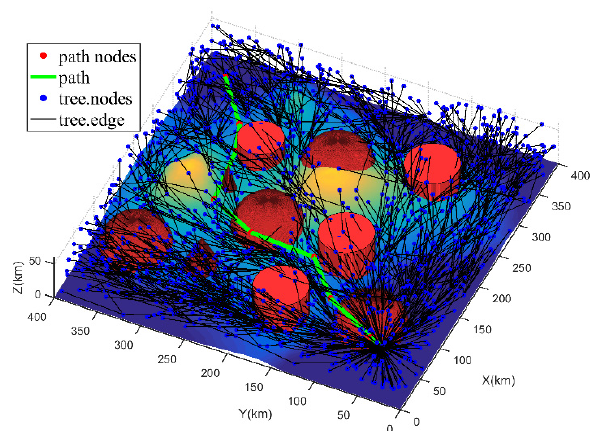
Figure 8. Directed tree graph and path of RRT*. Table 4. Statistical results comparison between FC-RRT* and RRT*.